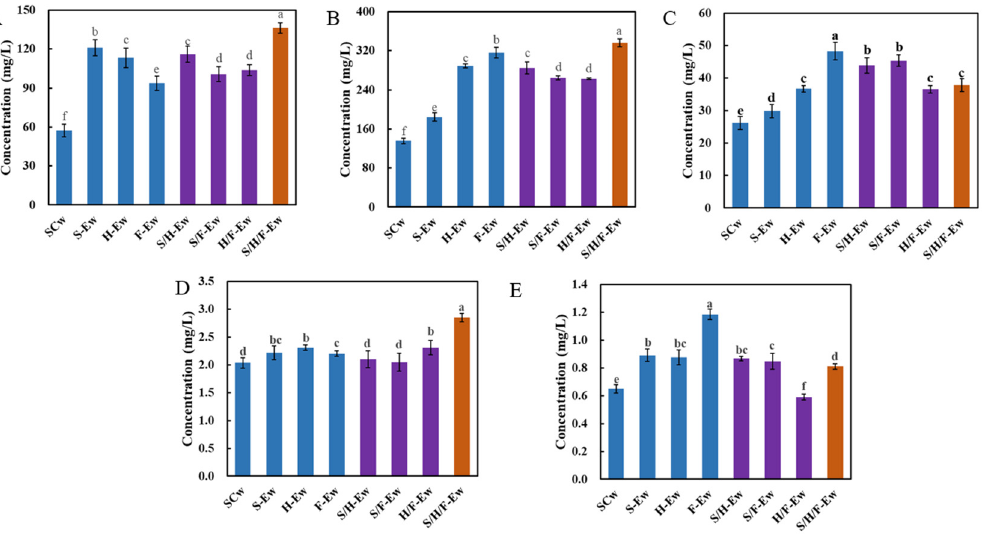
Figure 3. Fermentative aroma compound content in wines. ( A ) Benzene derivatives; ( B ) higher alcohols; ( C ) esters; ( D ) fatty acids; ( E ) carbonyl compounds. Different letters on the histogram showed significant difference ( p < 0.05).